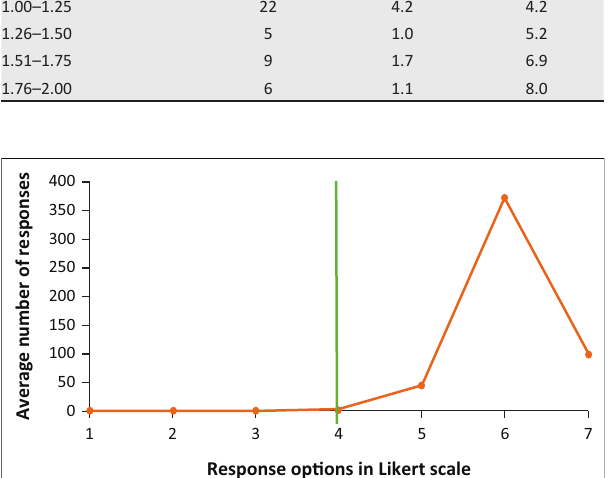
FIGURE 3: SERVPERF distribution illustrated by means of frequency polygon.